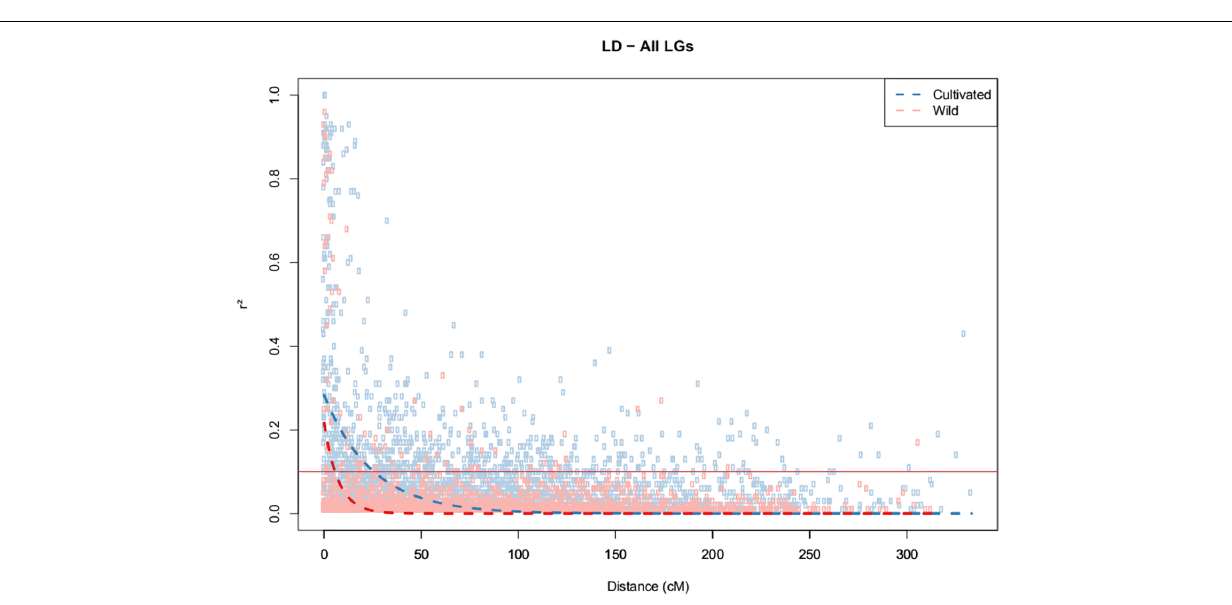
Tang et al. (2016) to map the SNPs. The SNPs positioned on the map are named in reference to the location of alignment with the